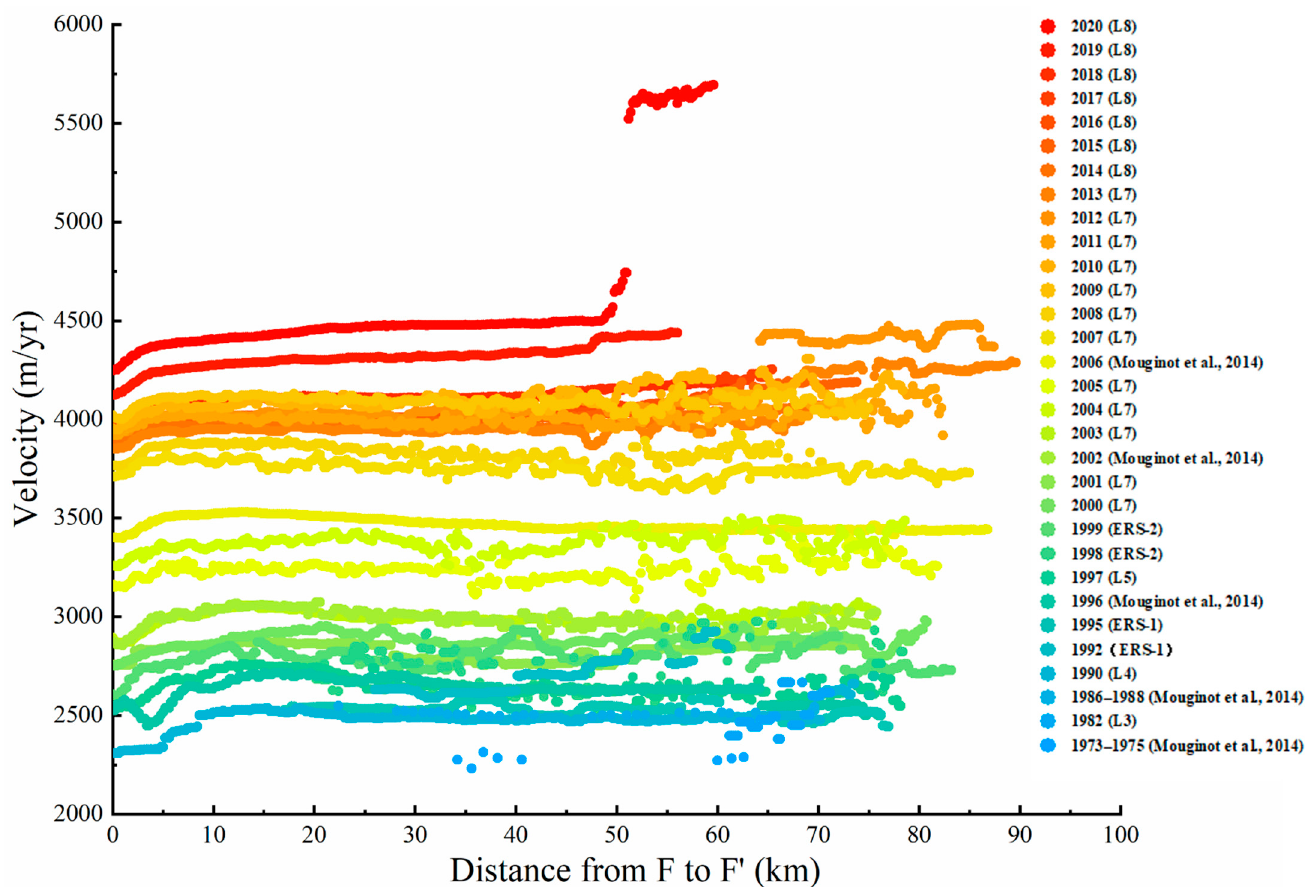
Figure 2. The ice flow velocity profiles along F-F’ from 1973 to 2020. Velocities of 1973–1975, 1986–1988, 1996, 2002, and 2006 were retrieved via NSIDC [27,41] .